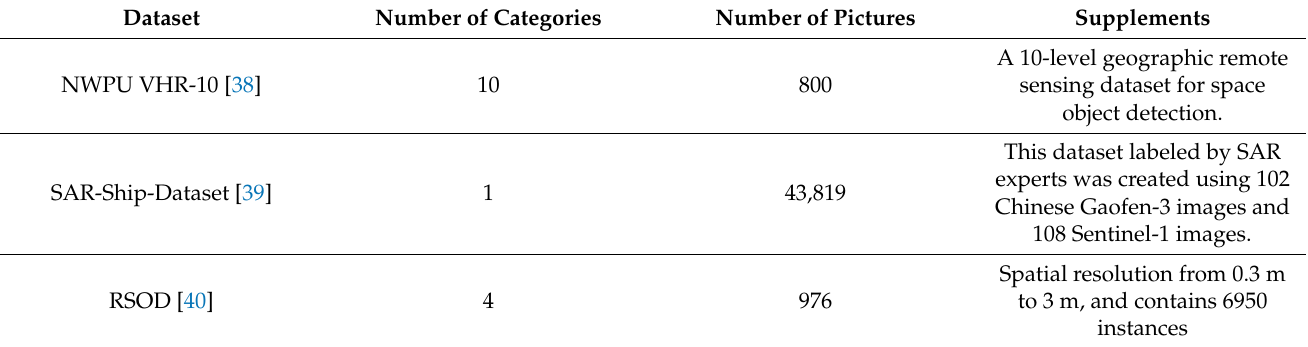
Table 1. The experimental